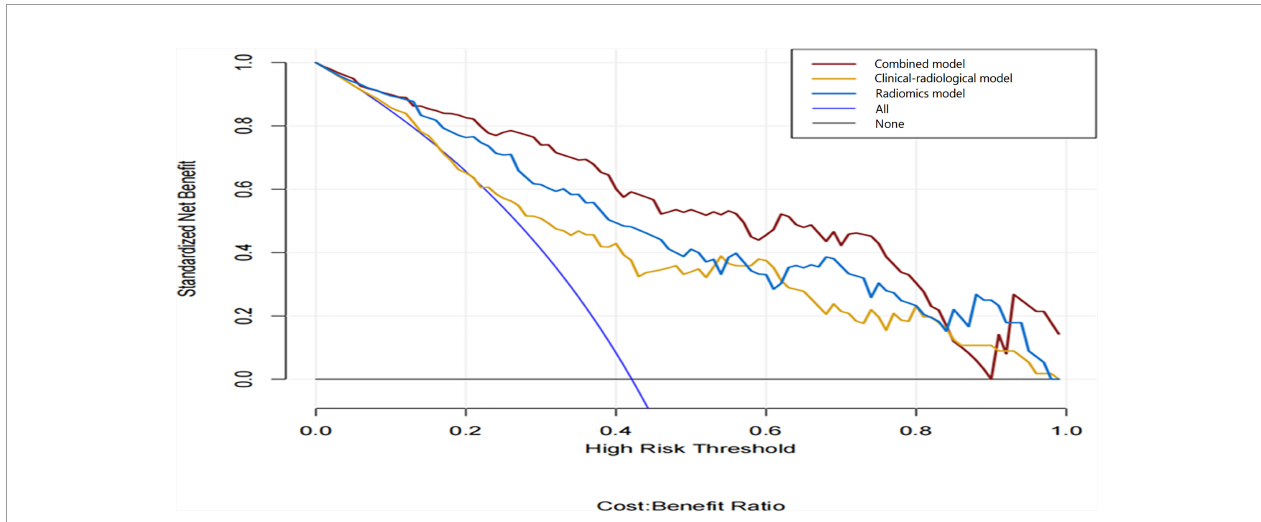
FIGURE 6 | Decision curve analysis of the three models. The y-axis and the x-axis show the standardized net bene fi t and the threshold probability, respectively. Among the three models, the combined model (red line) has a higher net bene fi t than the clinical – radiological model (yellow line) and the radiomics model (blue line) within a wide range of threshold